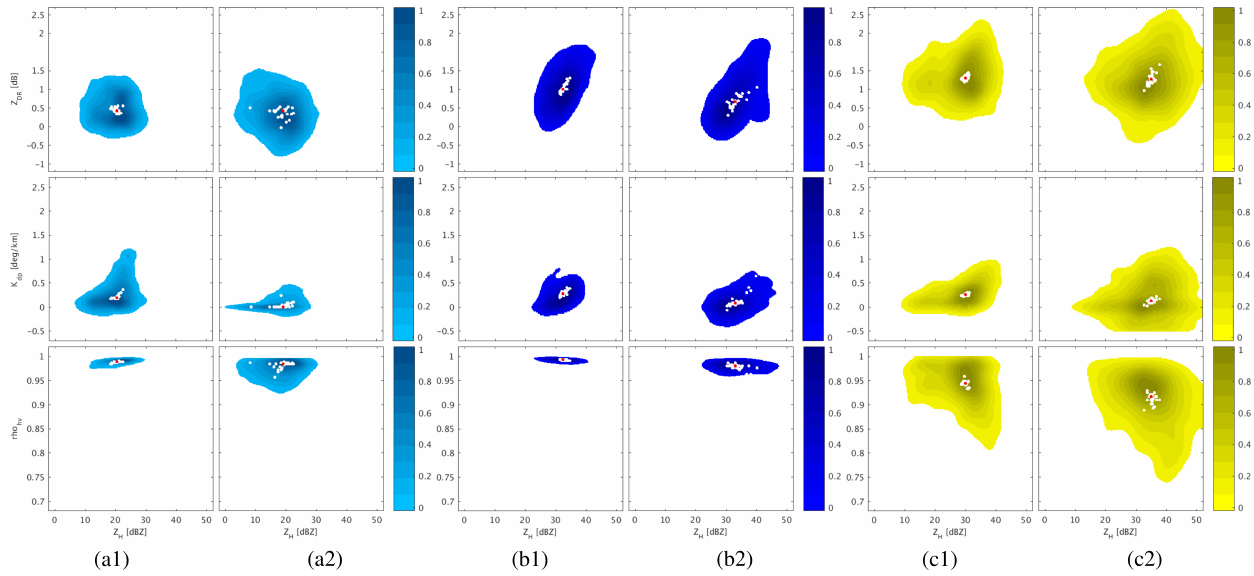
Figure 5. Examples of PDFs estimated by means of kernel density estimation (KDE) along with the centroids from all iterations (white) and final centroids (red), for MXPol (1) and DX50 (2) datasets: (a) AG, (b) RN, (c) WS.